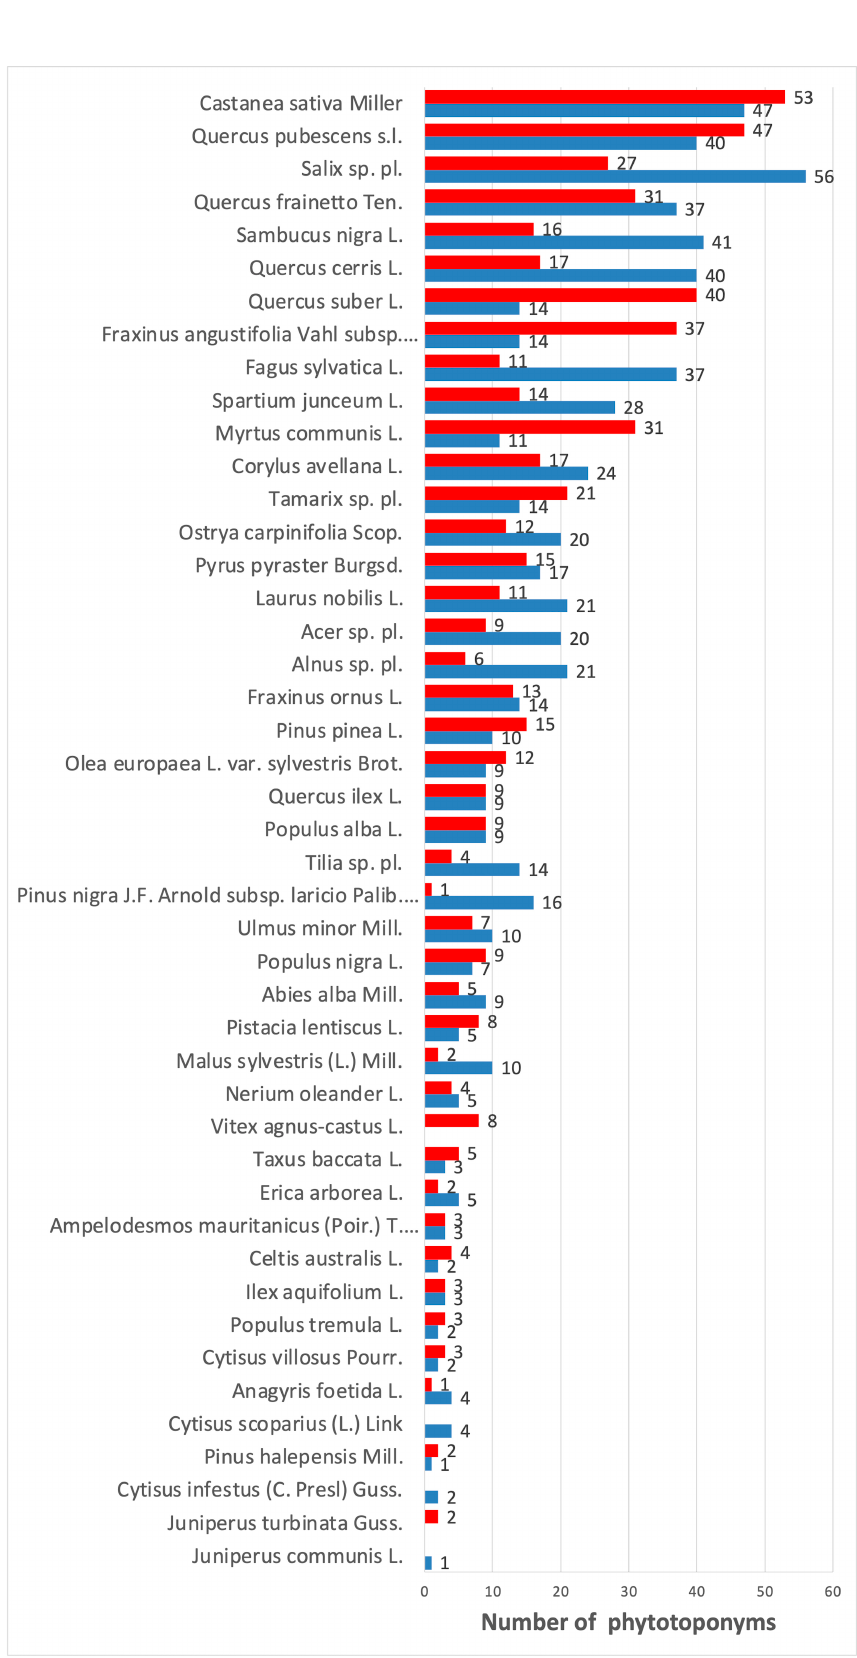
Figure 5 . Number of phytotoponyms per species and agreement with current forest vegetation. Blue, agreement with current forest vegetation; red, no agreement.